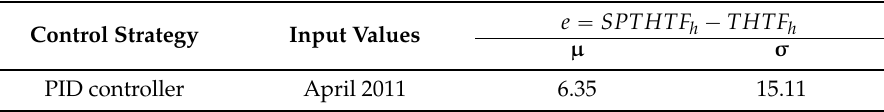
Table 4. Numerical results of simulation with PID (April 2011).